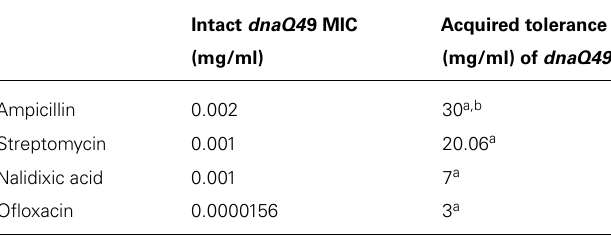
Table 1 |Acquired tolerance of dnaQ49 to